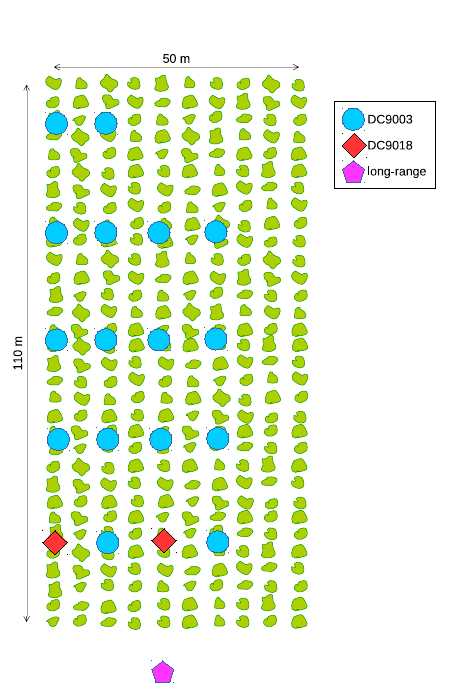
Figure 9. Final locations of the deployed motes in the